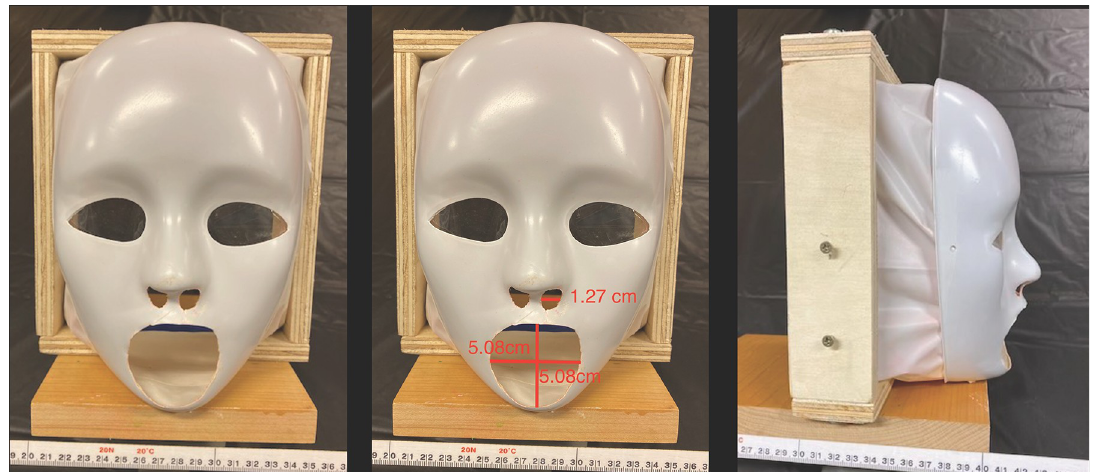
Fig 1. Dimensions and different views of M1. A white metric measuring tape with centimeter and millimeter markings is shown in each figure. (A) The front of the mannequin head is displayed. The head consists of a wooden base and frame as well as plastic connected to the mask and frame. (B) The measurements of the nostrils and mouth are shown. (C) The side view of M1 is displayed as well as two screws which were used to simulate the human ear to anchor the